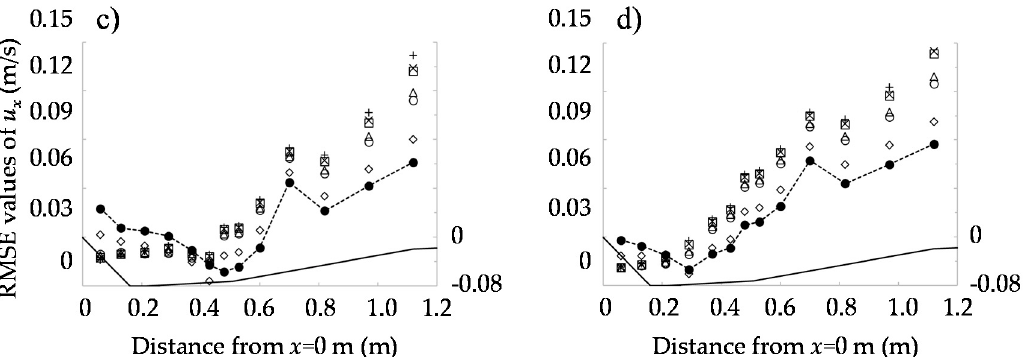
Figure 6. Root mean square error (RMSE) values of flow velocity in stream-wise direction with various bottom roughness height formulas: ( a ) Fully depth-averaged (0 < z / h 0 < 1) RMSE with k- ε model; ( b ) Fully depth-averaged with k- ω shear-stress transport (SST) model; ( c ) Partially depth-averaged (0 < z / h 0 < 0.15) k- ε model for the lower part; ( d ) Partially depth-averaged (0 < z / h 0 < 0.15) k- ω SST model.